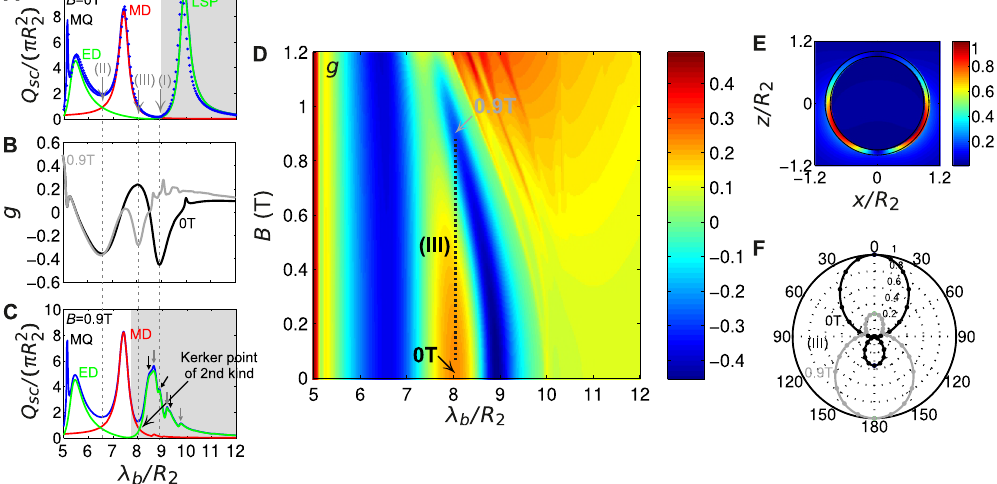
Figure 2: Scattering cross sections, asymmetry parameter, near field and polar (far field) plots to illustrate functional spherical antenna design for directionality inversion. (A) Scattering cross section spectrum of a core – shell particle of total radius R 2 (cid:2) 10 μ m, with core radius R 1 (cid:2) 0 . 9 R 2 , under null external magnetic fi eld. Blue curve: scattering cross section, i.e., including all terms of Eq. (5) up to a truncation order that ensures convergence; blue dots: scattering cross section via HFSS; red solid line: MD contribution to the scattering cross section; green solid line: ED contribution to the scattering cross section; point (I): Kerker point of second kind (back-scattering) at λ b / R 2 (cid:2) 8 . 93; point (II): Kerker point of second kind (back-scattering) at λ b / R 2 (cid:2) 6 . 6; point (III): Emerged forward-scattering point at λ b / R 2 (cid:2) 8 . 04. Gray region corresponds to wavelengths with plasmonic behavior of the shell material. (B) Scattering-asymmetry parameter within the given spectral window.Black:nullmagnetic fi eld;gray:0.9T.(C)Scatteringcrosssectionspectrumforthesamesetupasin(A)butforexternalmagnetic- fi eld bias 0.9 T. Legends are the same as in (A). The small black/gray arrows indicate the mode splitting due to magnetic bias (see text). Black arrows: m (cid:2) − 1 non-degeneracy; gray arrows: m (cid:2) + 1 non-degeneracy. The large black arrow indicates the location of the Kerker point of secondtypewhichnow,under0.9Tmagnetic fi eld,coincideswithpoint(III).Grayregioncorrespondstowavelengthswithplasmonicbehavior of the shell material. (D) Mapping of asymmetry parameter g versus B and λ b / R 2 . (E) Normalized magnitude | E | of the total electric fi eld on xz - plane for the plasmonic resonance at λ b / R 2 (cid:2) 9 . 92 appearing in (A). (F) Polar/bistatic cross section (far fi eld) for antenna operation at the preferential point λ b / R 2 (cid:2) 8 . 04. Black: forward-scattering at 0 T; gray: back-scattering at 0.9 T. Curves: VIE; dots: λ / R (cid:2) 8 . 04. The dipolar resonances within the spectral 2 b range up to λ b / R 2 (cid:2) 8 . 9 are typical subwavelength reso- nances that stem from the high-index dielectric core, where the intersections between the ED – MD and MD – LSP modes correspond to Kerker points of the second kind, as de fi ned in [23]. We point out here that, for a single dielectric sphere [23], the fi rst intersection — as we move from higher to lower wavelengths — corresponds to the Kerker point of the fi rst kind where directional forward-scattering takes place, while, the second crossing, corresponds to the second Kerker point where strong back-scattering occurs. How- ever, in our setup, due to the presence of an extra electrical dipolar mode, i.e., the LSP of the shell, there is an extra Kerker point of the second type, which is marked as (I) in Figure 2A. To further clarify this, we examine the behavior of the dominant dipolar terms C M , C N versus λ b / R 2 . Both Figure 2D. We then return toFigure 2Bandplot g versus λ b / R 2 1 , 1 1 , 1 ) (cid:2) − Im ( C M ) for fi xed B (cid:2) 0 . 9 T (gray curve). This curve reveals a local points (I), (II) satisfy the conditions Im ( C N 1 , 1 1 , 1 (cid:14)(cid:14)(cid:14)(cid:14) (cid:14)(cid:14)(cid:14)(cid:14) (cid:14)(cid:14)(cid:14)(cid:14) (cid:14)(cid:14)(cid:14)(cid:14) minimum in the same position where g ( B (cid:2) 0 T ) has its 2 (cid:2) 2 [23] that should hold for a point to be of and C M C N 1 , 1 1 , 1 maximum. To elucidate the physics behind this mechanism, the second Kerker type. These properties are interpreted as two local minima in g — in the absence of magnetic bias — the same setup as in Figure 2A, but now for B (cid:2) 0 . 9 T. It is